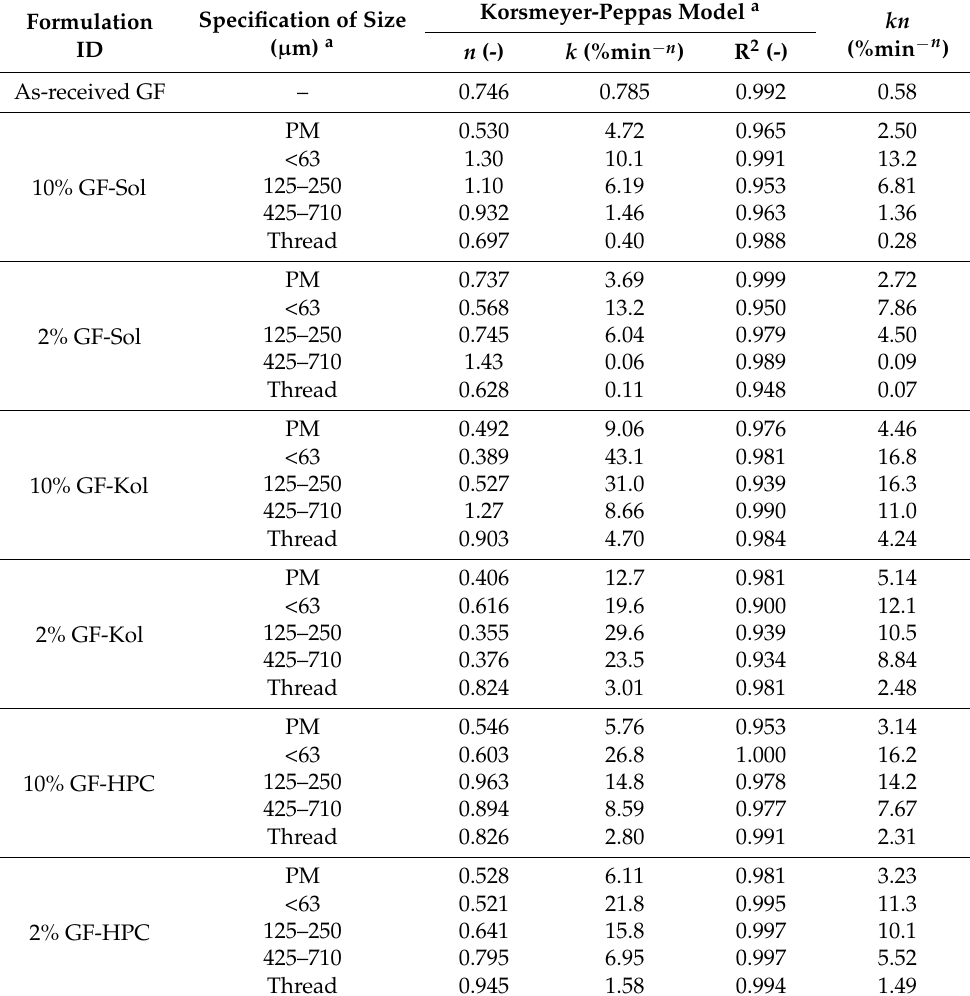
Table 4. Statistical analysis of the Korsmeyer–Peppas model fit to the drug release profiles of extrudates (thread and powders) with various polymers and size fractions (8.9 mg GF dose).